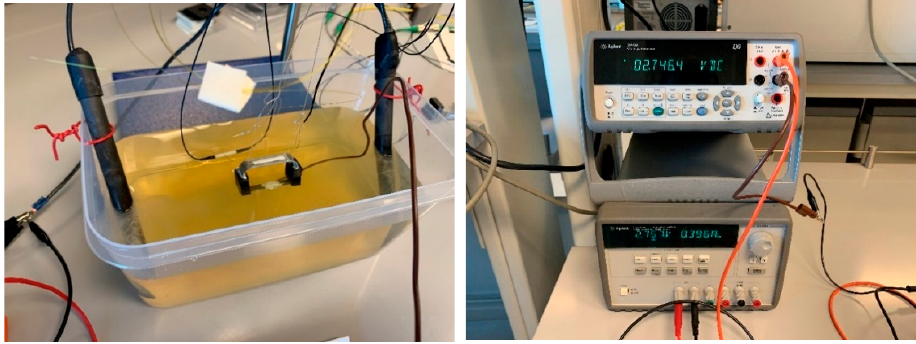
Figure 16. Start of the experiment.